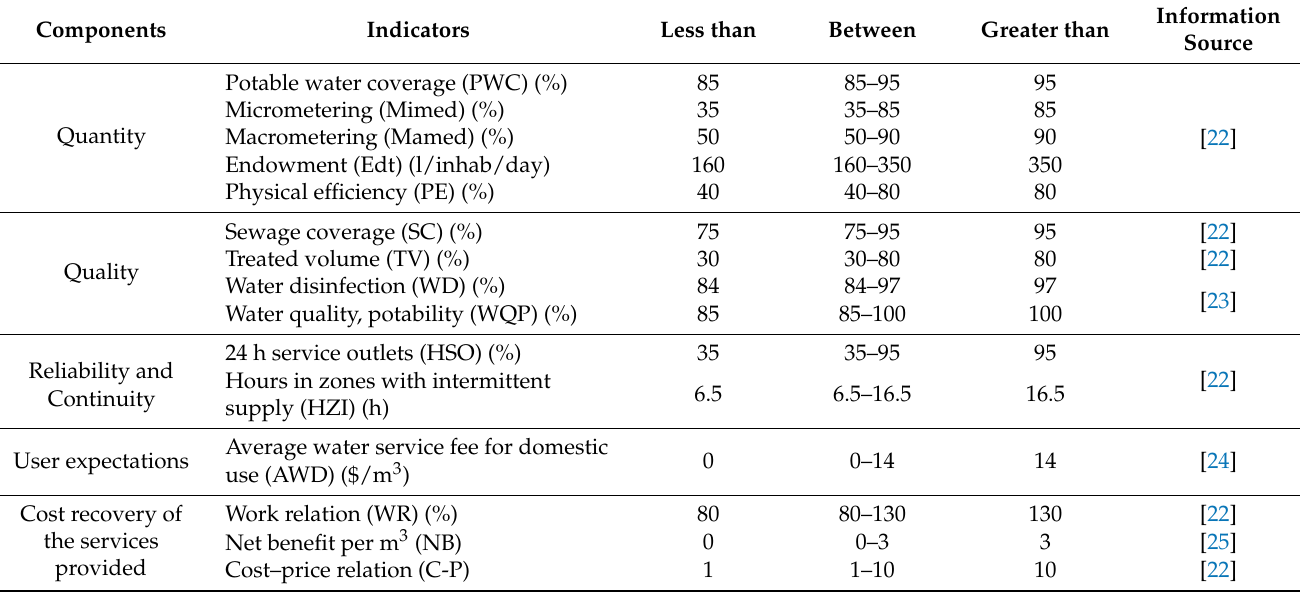
Table 1. Evaluated water management